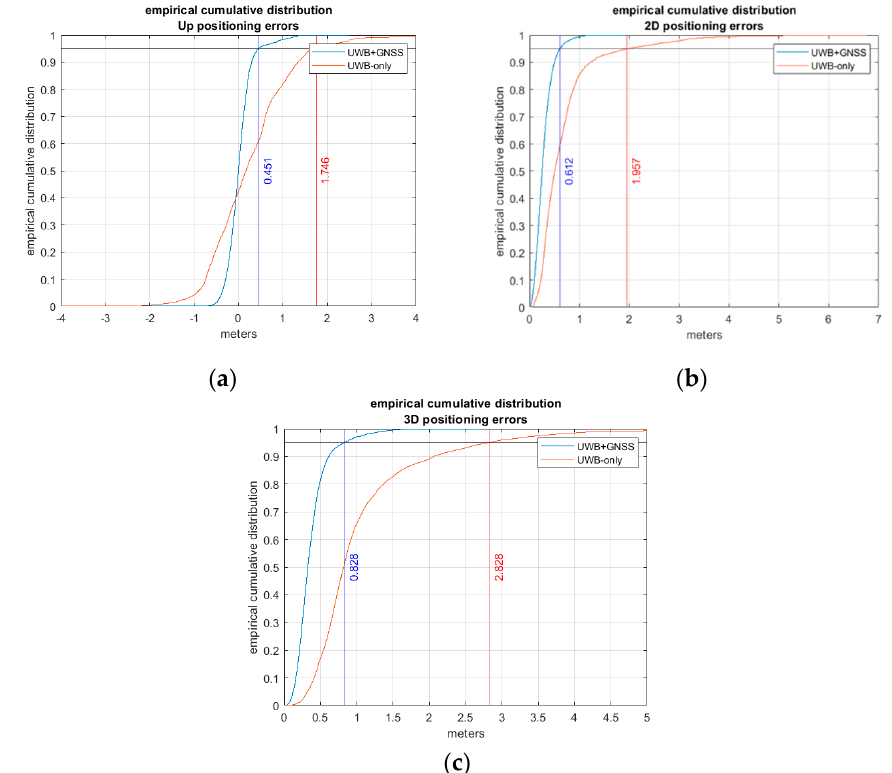
Figure 11. Empirical cumulative distribution of the positioning errors expressed in meters of UWB solution vs. the proposed solution for ( a ) the vertical, ( b ) horizontal and ( c ) 3D component.